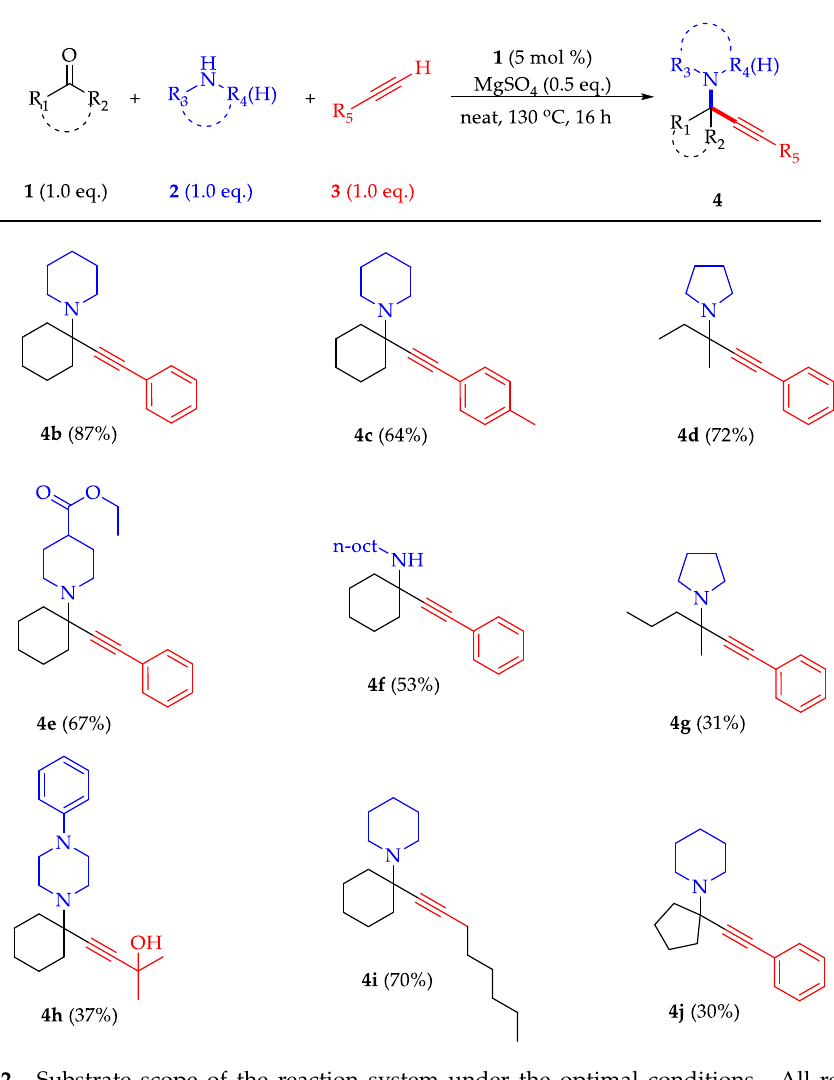
Scheme 2. Substrate scope of the reaction system under the optimal conditions. All reactions were performed on a 0.5 mmol scale and isolated yields after column chromatography are shown in parentheses.